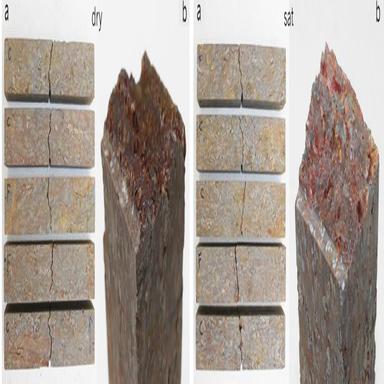
XA specimens tested for flexural strength (4-points bending test): (a) front views and (b) detail from a rupture surface interface.